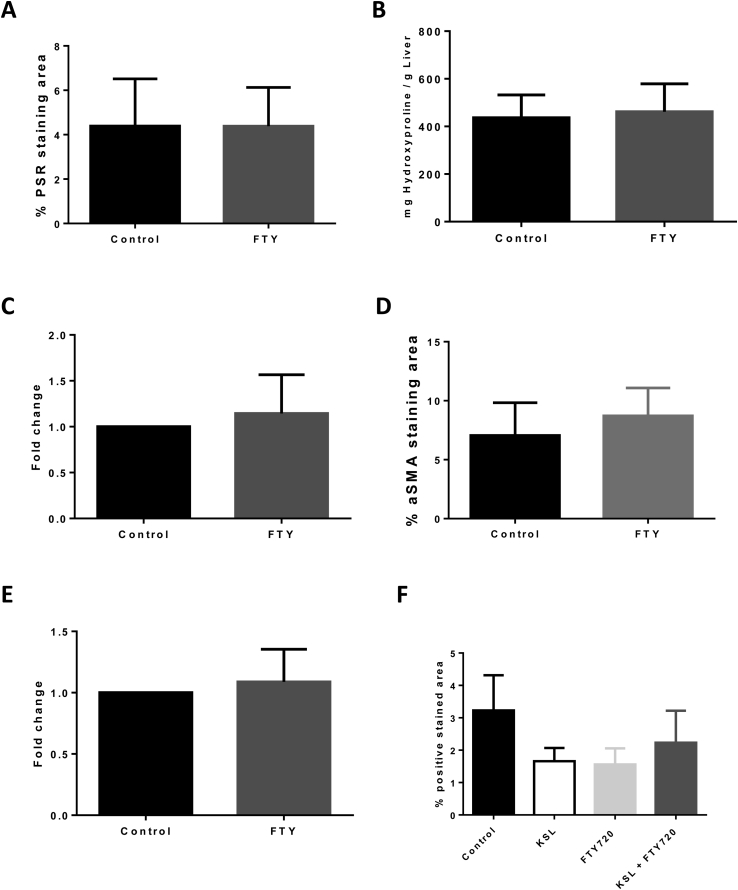
Use of FTY alone in model of chronic liver injury. Chronic liver injury was induced in age- and sex-matched C57/BL6 mice by twice weekly intraperitoneal administration of carbon tetrachloride (1 mg/kg) in mineral oil for 6 weeks, mice then were allocated randomly to a treatment group. Mice in the control group continued to receive twice-weekly injections of intraperitoneal carbon tetrachloride until week 10 and were killed 72 hours after the final injection of carbon tetrachloride. Mice in the FTY720 treatment group received twice-weekly carbon tetrachloride in the same way as control mice but in addition received 3 times weekly FTY720 (1 mg/kg) via intraperitoneal injection from the start of week 7, mice were killed at the start of week 10, 72 hours after the final injection of carbon tetrachloride. (A) Formalin-fixed paraffin-embedded liver tissue sections from control mice (black bars) and mice treated with FTY720 (grey bars) were stained for picrosirius red. Six random nonoverlapping images were obtained from each section and staining was quantified as a percentage of the image positive for picrosirius red using ImageJ software (n = 12–13 in each group; means ± SD % area stained shown; P = NS). (B) Hydroxyproline content in samples of liver tissue from control mice (black bars) and mice treated with FTY720 (grey bars) was determined and expressed as milligrams of hydroxyproline per gram of liver tissue (n = 12–13 in each group; means ± SD hydroxyproline content shown; P = NS). RNA was extracted from liver tissue of control mice (black bars) and mice treated with FTY720 (grey bars) and using quantitative reverse-transcription polymerase chain reaction gene expression of (C) col1a1 and (E) α-SMA were determined, normalized to glyceraldehyde-3-phosphate dehydrogenase expression, and relative to control mice using the 2-ddCT method (n = 12–13 in each group; means ± SD fold change shown; P = NS). (D) Formalin-fixed paraffin-embedded liver tissue sections from control mice (black bars) and mice treated with FTY720 (grey bars) were stained for α-SMA. (F) Six random nonoverlapping images were obtained from each section and staining was quantified as a percentage of the image positive for CD45 using ImageJ software (n = 12–13 in each group; means ± SD % area stained shown; P = NS).